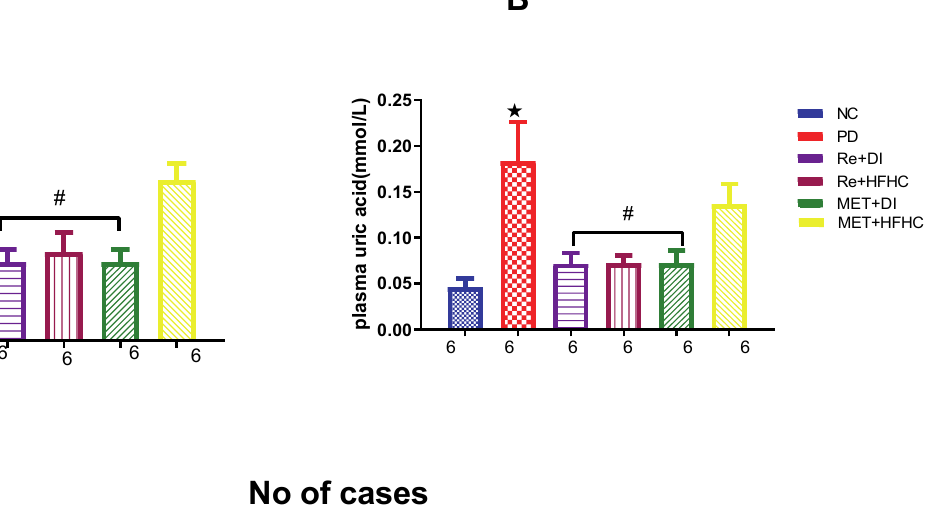
Figure 14. ( A , B ) Plasma and urinary albumin concentrations in normal control (NC), prediabetic control (PD), metformin and diet intervention (MET + DI), metformin and high-fat/high-carbohydrate diet (MET + HFHC), rhenium (V) compound and diet intervention (Re + DI) and rhenium (V) compound and high-fat/high-carbohydrate diet (Re + HFHC) groups after 12 weeks of treatment. Values are presented as means ± SEM (n = 6). (cid:70) p < 0.05 in comparison with NC; # p < 0.05 in comparison with PC, MET + DI, MET + HFHC, Re + DI and Re + HFHC.